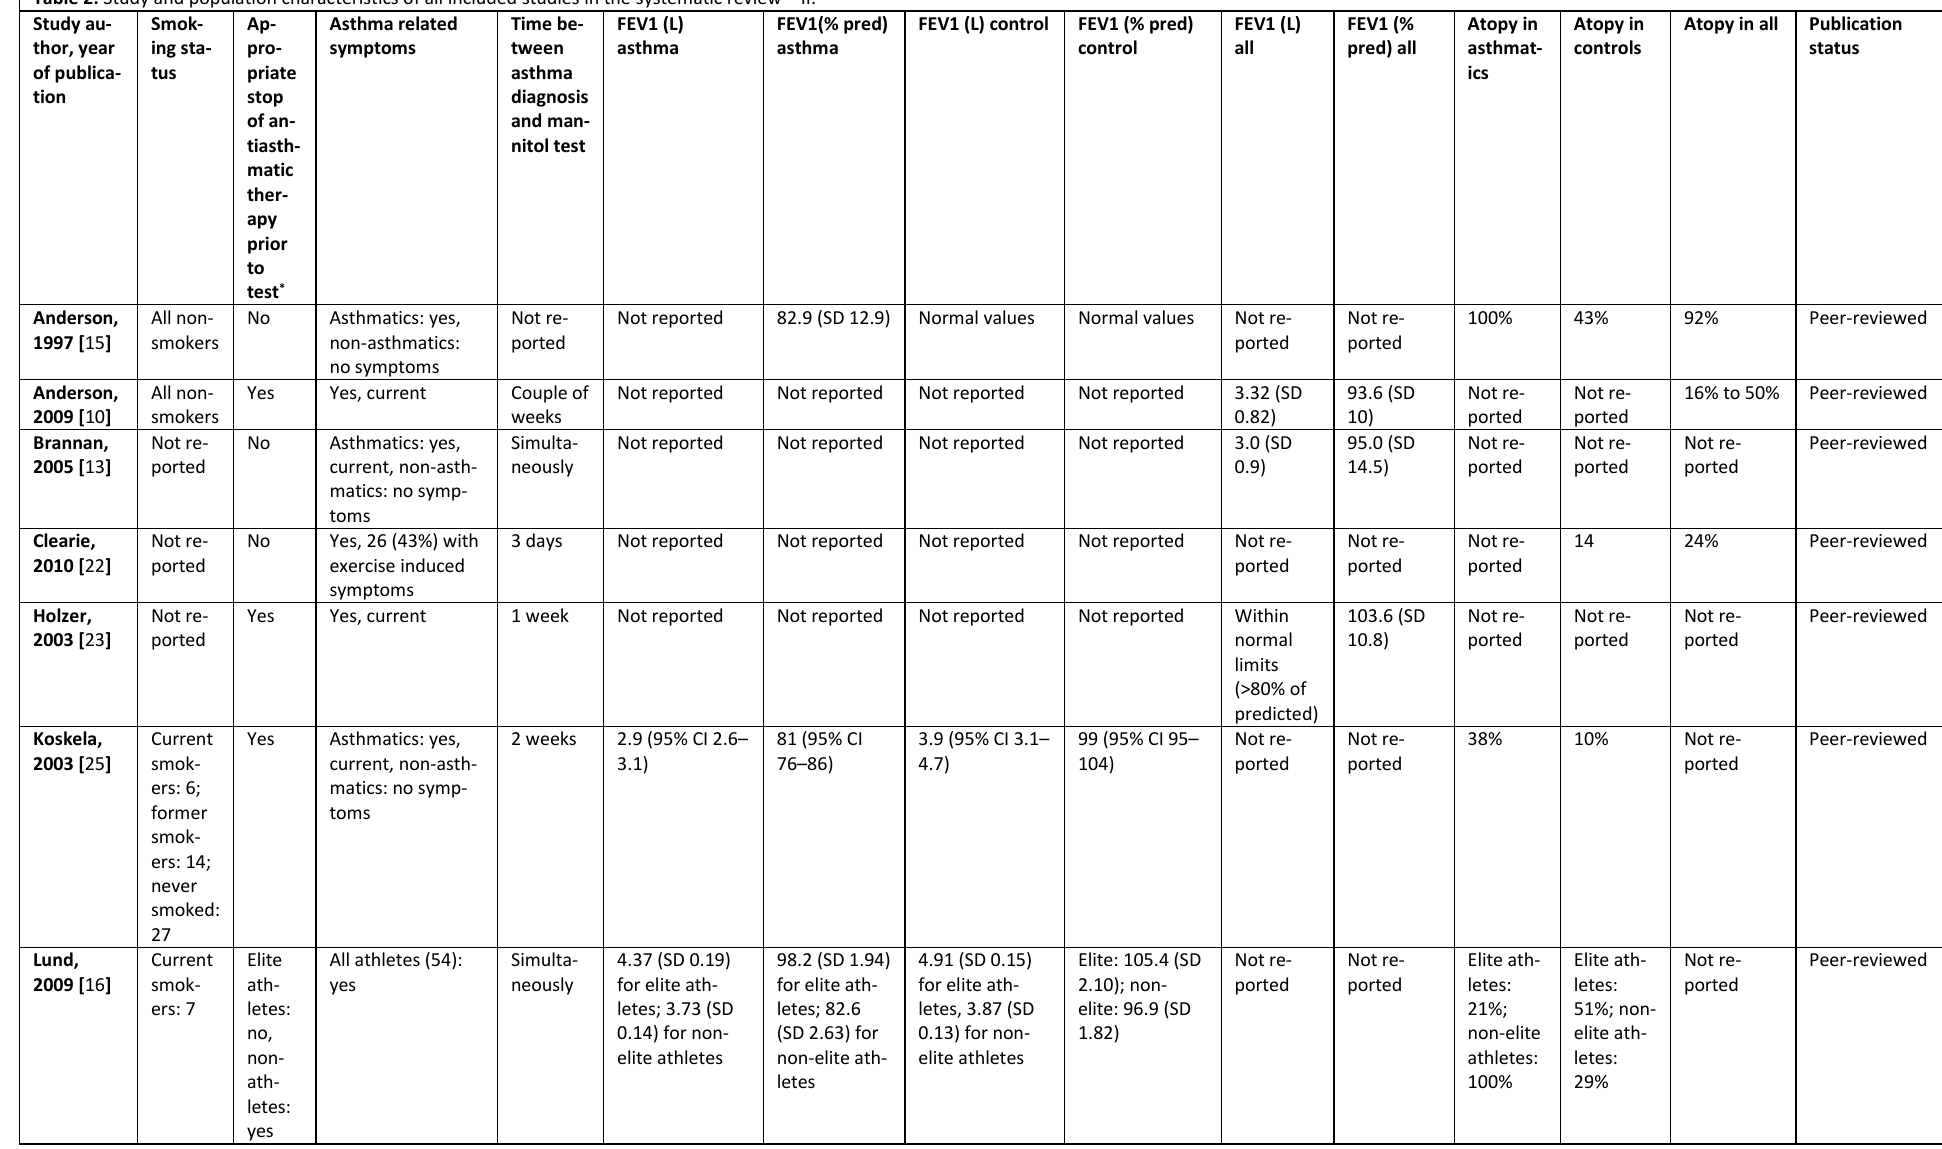
Table 2: Study and population characteristics of all included studies in the systematic review – II. Study au- Smok- thor, year ing of publica- tion